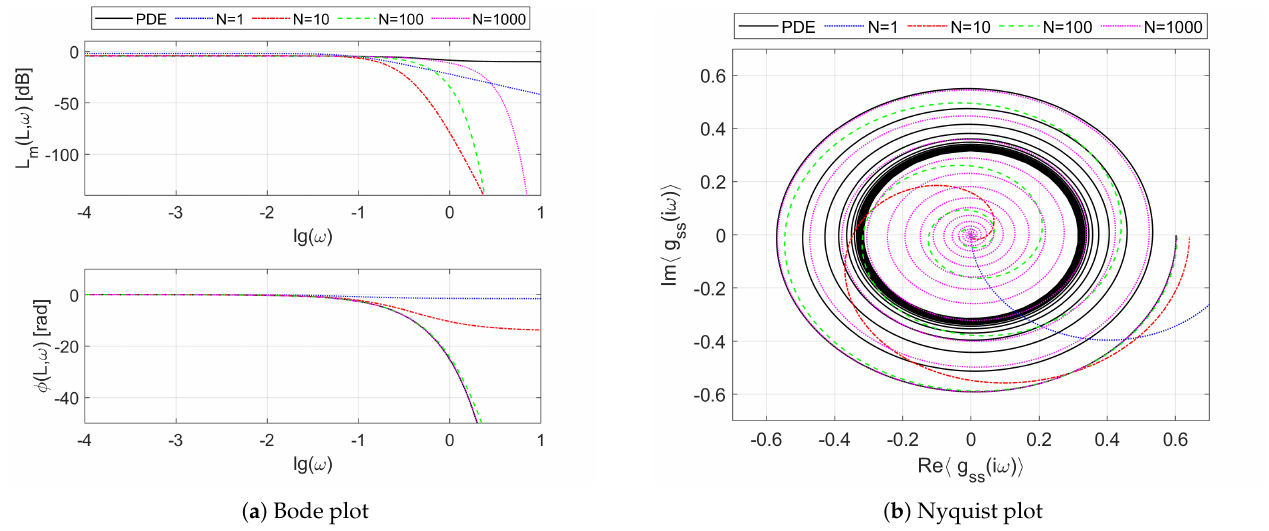
Figure 5. Frequency response g ss ( 0, i ω ) of the irrational transfer function model of the double-pipe counter-flow heat exchanger vs. frequency responses ˆ g ss ( l 1 , i ω ) of its approximate rational transfer function models for different N